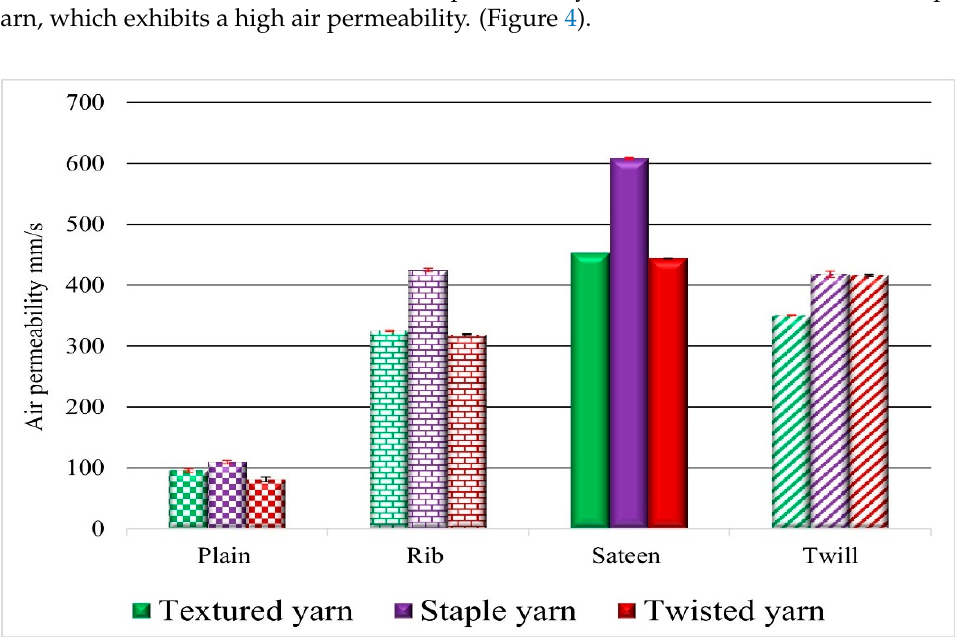
Figure 4. Overall air permeability test results.